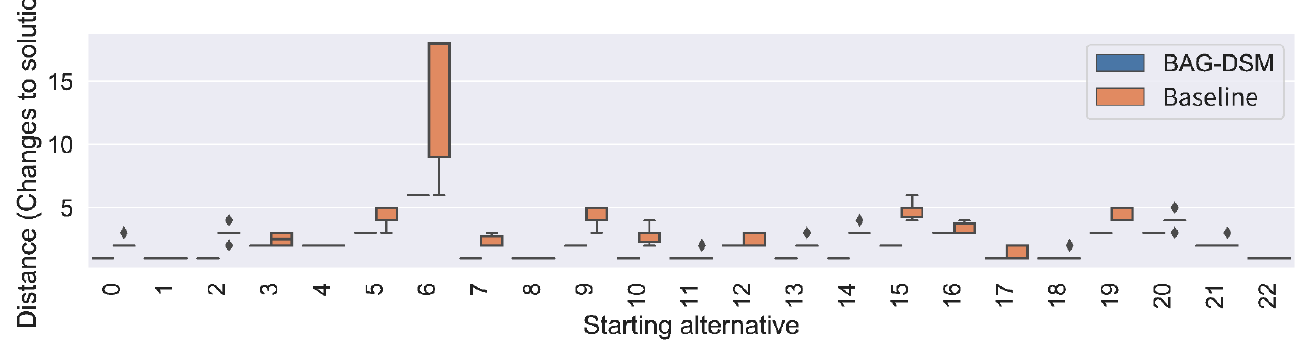
Figure 8. Boxplots for the distances (shorter is better) between the current alternative and the optimal alternative found by BAG-DSM (Bayesian) vs. baseline for the Landmark model.